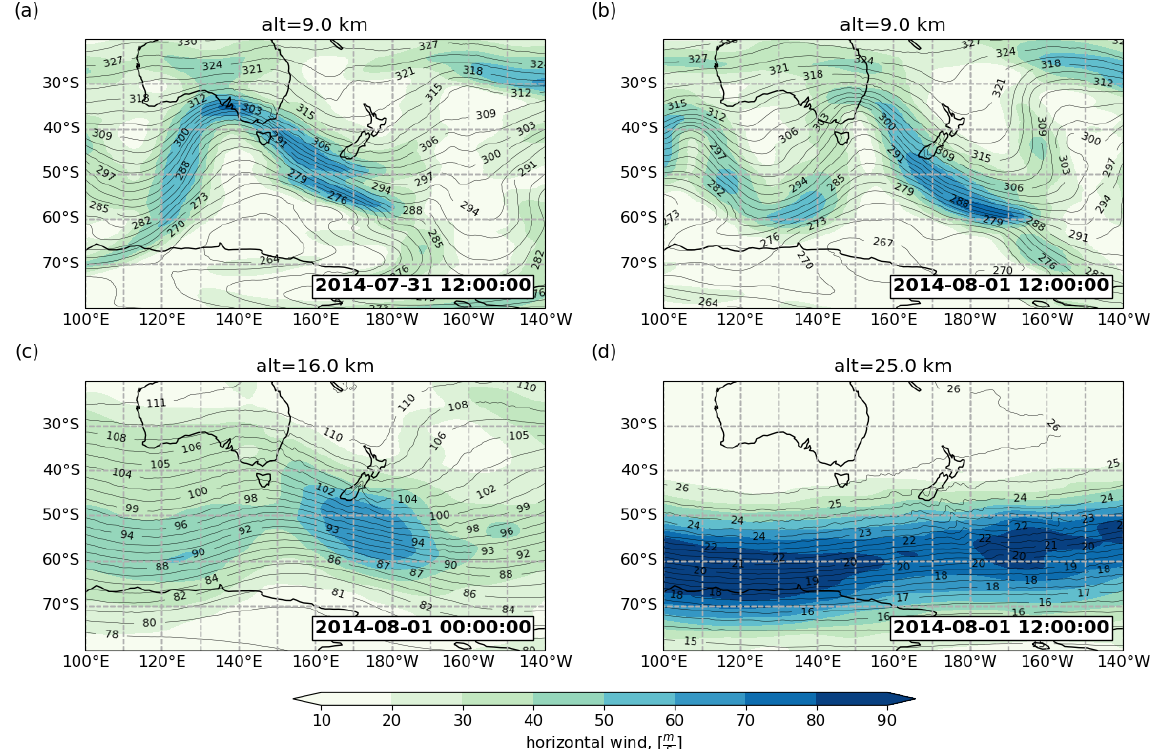
Figure 1. Tropospheric and stratospheric jet streams illustrated in horizontal wind speeds at different altitudes and times. The colour code shows horizontal wind speeds in metres per second (ms − 1 ) overlain by contours of the pressure in hectopascals (hPa) from ECMWF-IFS analyses. The panels show (a) 9km altitude on 31 July 2014 at 12:00UTC, (b) 9km altitude on 1 August 2014 at 12:00UTC, (c) 16km altitude on 1 August 2014 at 00:00UTC, and (d) 25km altitude on 1 August 2014 at